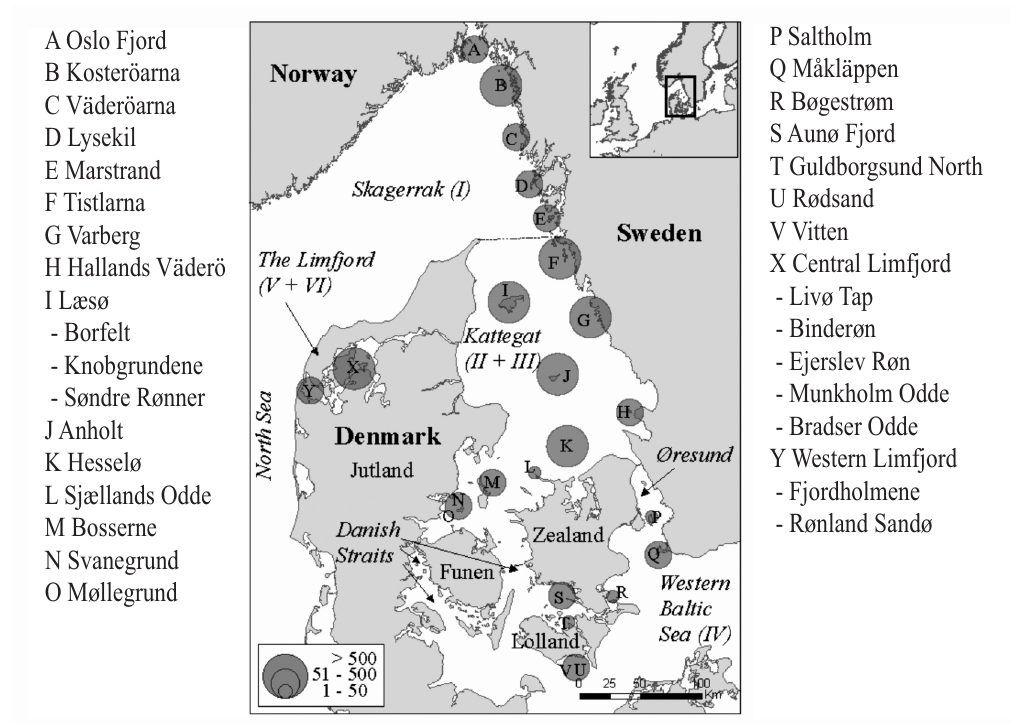
Fig. 1. Harbour seal haul-out sites in Southern Scandinavia. Subpopulations treated in this review are Skagerrak (I), Kattegat (II and III), western Baltic (IV), and Limfjorden (V and VI). Roman numerals refer to sub-units used for management and aerial